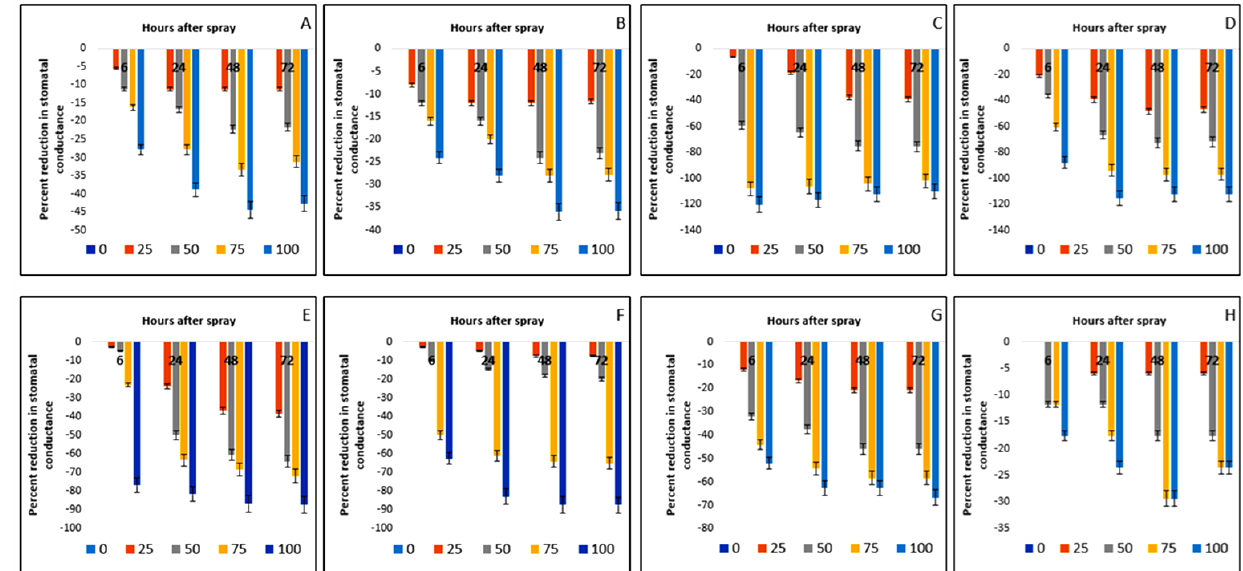
Figure 10. Reduction (%) of stomatal conductance of several crops and weeds due to the effect of parthenium leaf methanol extract: ( A ) -Bambara groundnut; ( B ) -Maize; ( C ) - D. sanguinalis ; ( D ) - E. A )—Bambara groundnut; ( B )—Maize; ( C )— D. sanguinalis ; indica ; ( E ) - A. conyzoides ; ( F ) - C. iria ; ( G ) - E. hirta , and ( H ) - C. difformis . of parthenium leaf methanol extract: ( ( D )— E. indica ; ( E )— A. conyzoides ; ( F )— C. iria ; ( G )— E. hirta , and ( H )— C. difformis